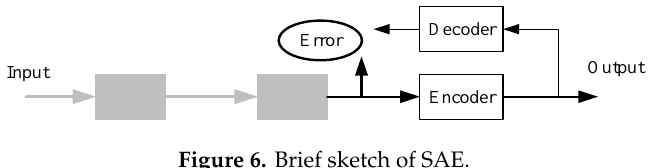
Figure 6. Brief sketch of SAE.